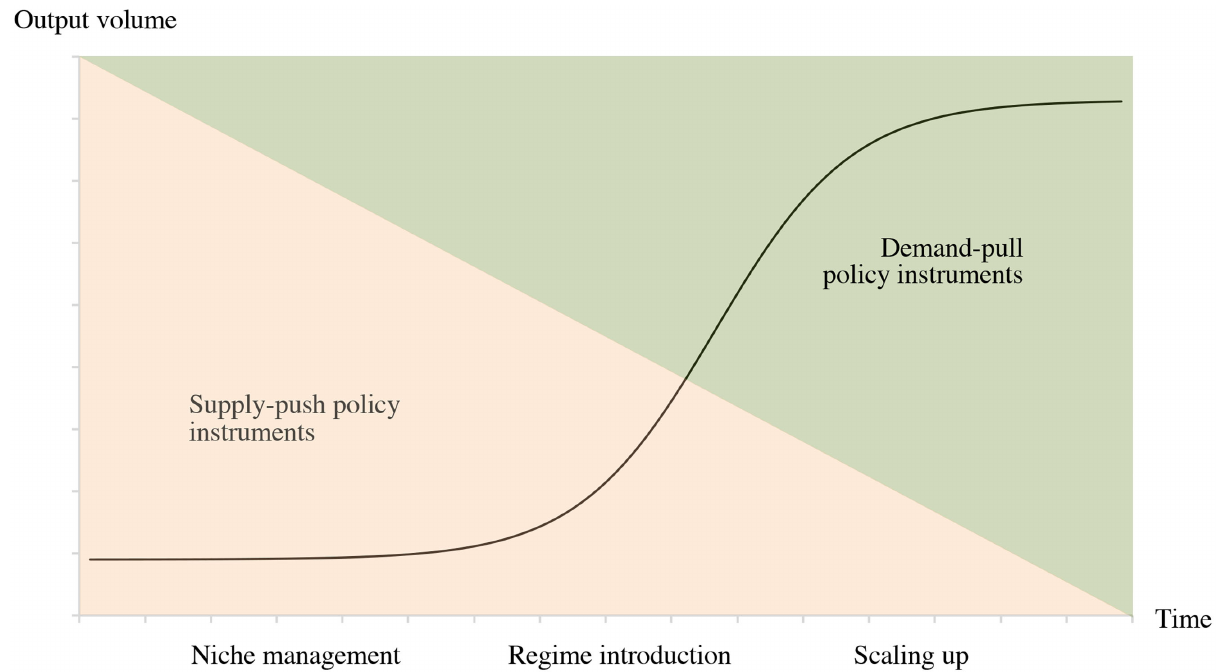
Frontiers in Climate |